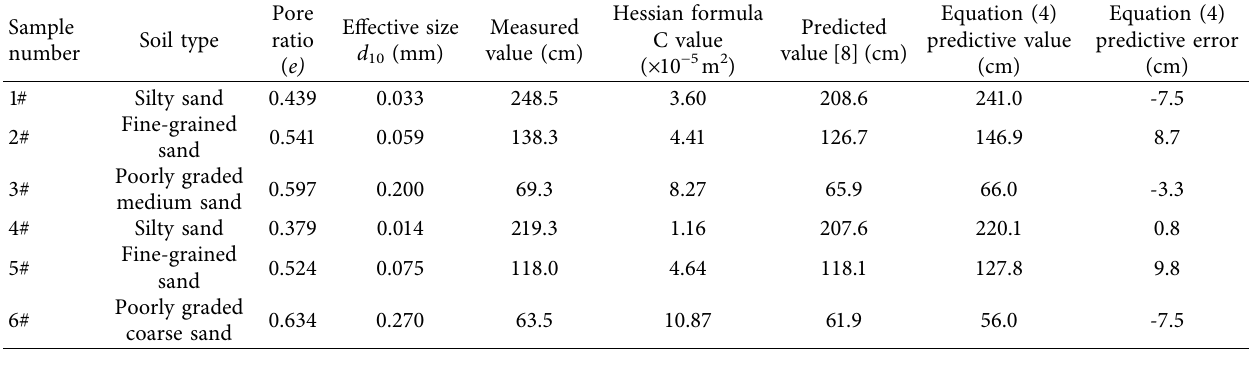
Table 4: The comparison of the measured and predicted values of h Sample